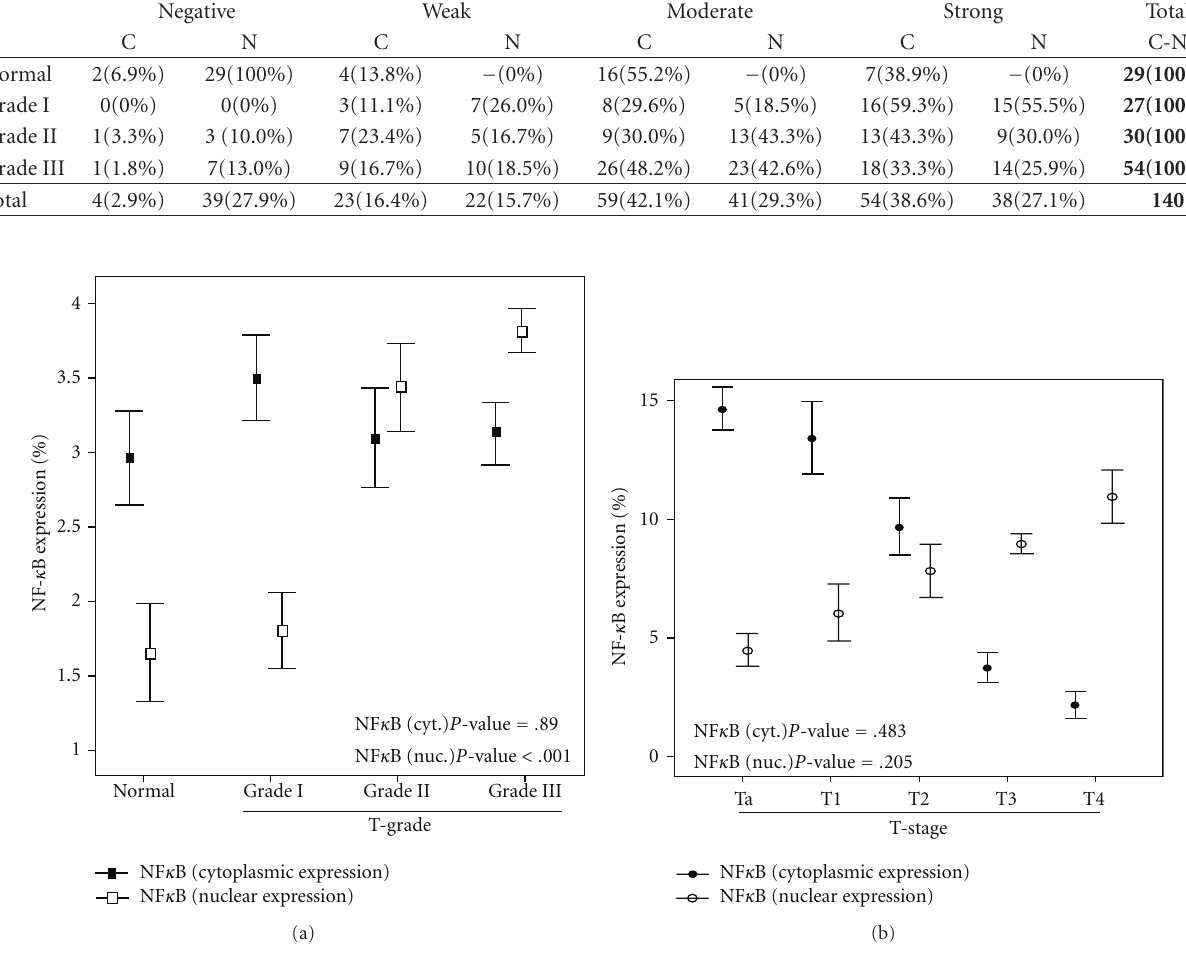
κ B (cyt.) P -value = . 89